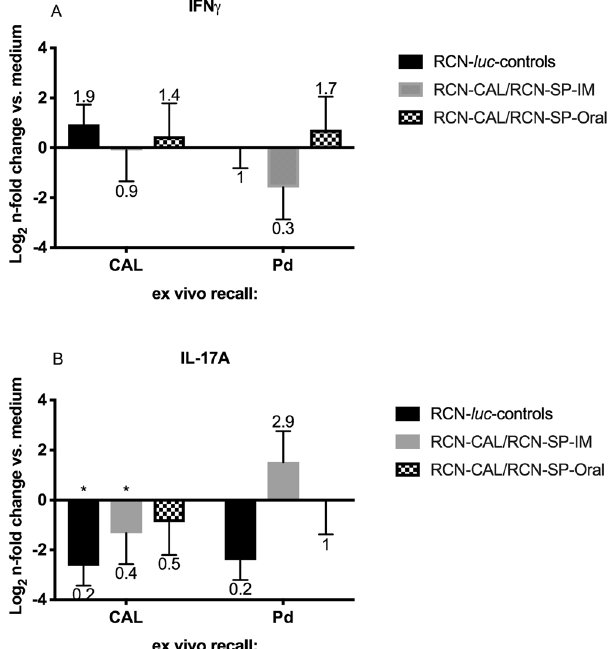
Figure 7. Expression of IFN- γ ( A ) and IL-17A ( B ), measured by RT-PCR, in pooled spleen and axillary lymph nodes of vaccinated Myotis lucifugus after challenge with Pseudogymnoascus destructans (Pd) and ex vivo recall with calnexin or Pd . Bats had been vaccinated with raccoon poxviruses (RCN) expressing calnexin and serine protease (RCN-CAL/RCN-SP), via intramuscular (IM; n = 8) or oral (n = 7) administration, or sham vaccinated with RCN expressing luciferase (RCN- luc ; n = 3). Bars and error bars represent average n-fold changes (indicated by the number above the error bar) and standard errors, normalized to the non-stimulated (medium) control. Values marked with an asterisk are significantly different from the medium control at P <